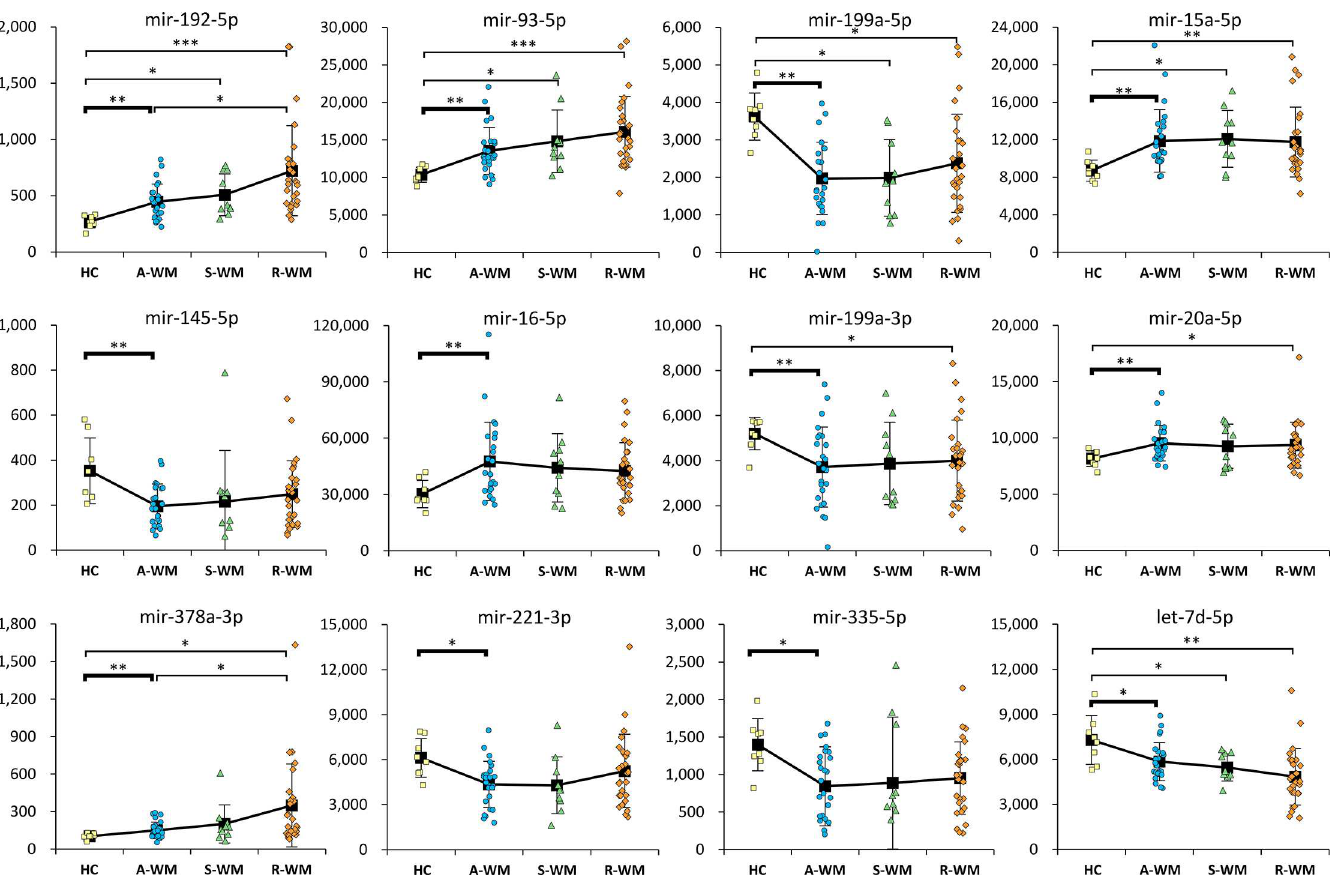
Fig 2. Exosomal miRNAs differentially expressed in patients with A-WM compared to healthy controls. Distribution (Mean + SEM) of microRNA expression in Healthy Controls (HC) or WM patients at progressive stages of disease (A-WM = Asymptomatic WM, S-WM = Symptomatic naive WM and R-WM = Relapsed WM) measured by the Abcam Firefly Multiplex circulating miRNA assay (33-plex) for miRNAs with a statistically significant difference of expression between the A-WM and HC groups. P -values were determined by a two-sample t-test with Benjamini-Hochberg correction applied for False Discovery Rate